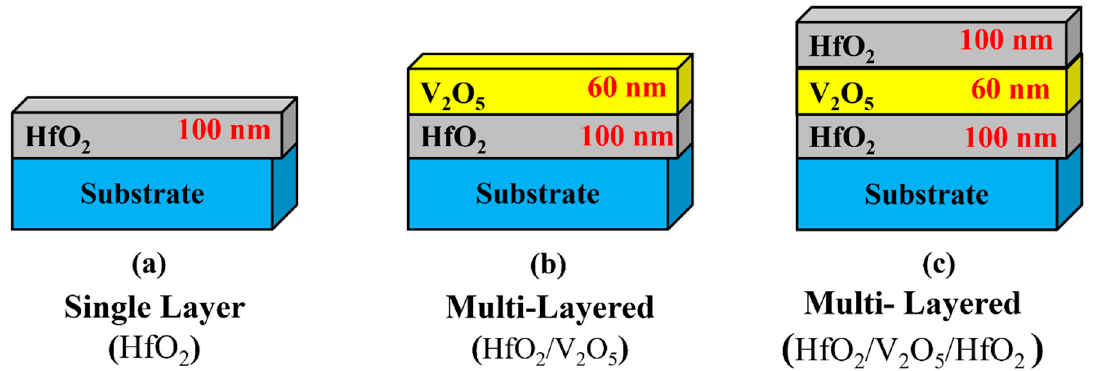
Figure 1. Schematic illustrations of ( a ) HfO 2 ; ( b ), HfO 2 /V 2 O 5 ; and ( c ) HfO 2 /V 2 O 5 /HfO 2 thin films.